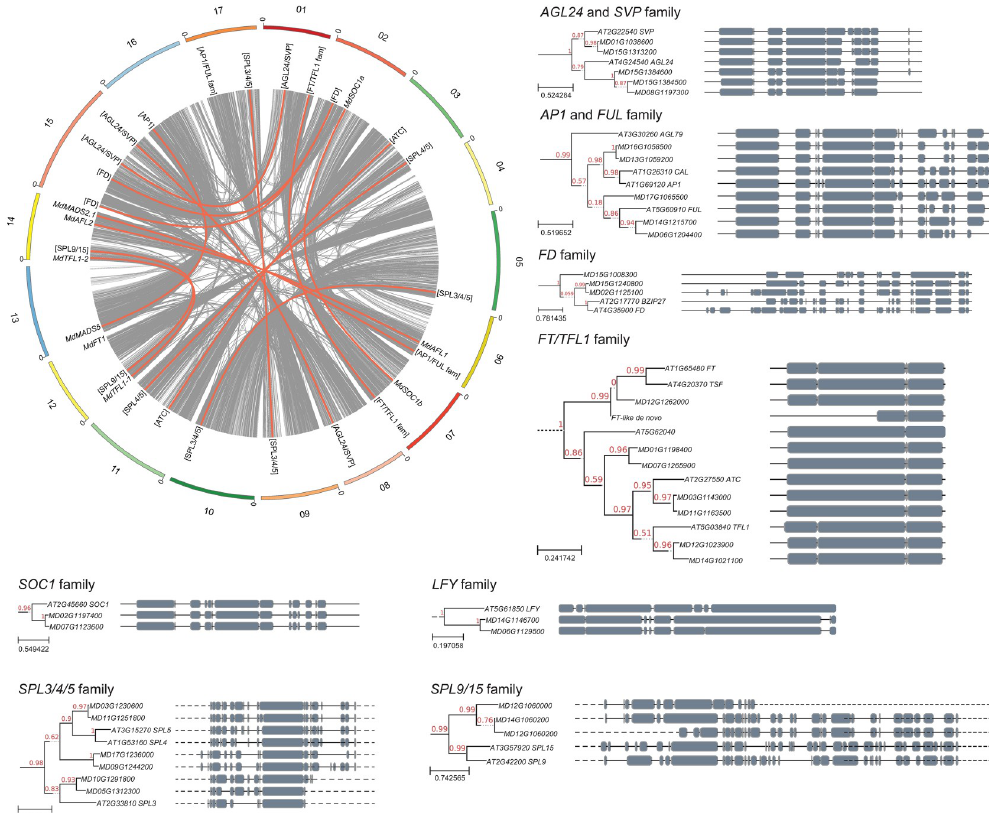
Fig 3. Analysis of genomic collinearity and phylogeny for 15 flowering gene families. The Circos plot at upper left depicts the chromosomal positions of flowering genes in the apple genome and their collinear relationships (red links). The background grey links represent the genomic collinearity within the apple genome. Chromosomes with significant homeology are depicted using similar colors. Phylogenetic trees are shown for each gene or gene family. For the phylogenetic trees, protein structure is depicted to the right of each gene, with conserved domains shown as grey